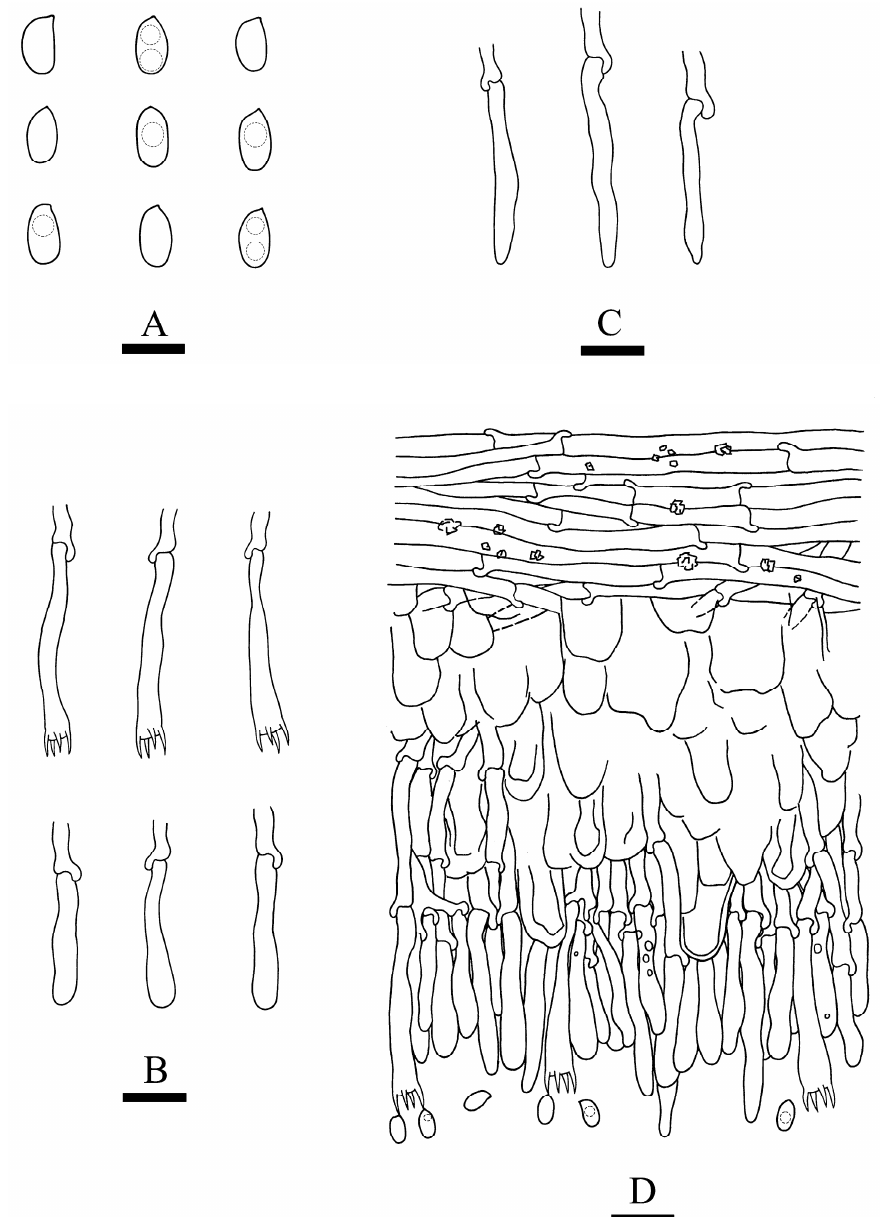
Figure 4. Microscopic structures of Crustodontia rhododendri (drawn from CLZhao 6168, holotype). ( A ) Basidiospores. ( B ) Basidia and basidioles. ( C ) Cystidioles. ( D ) A section of hymenium. Bars: ( A ) = 5 µm, ( B – D ) = 10 µm.